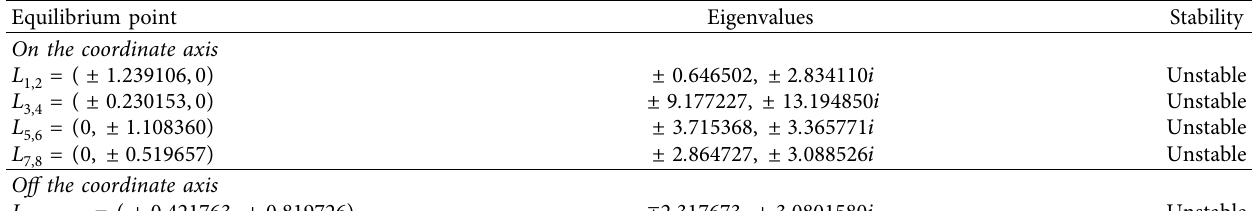
Table 4: Equilibrium points, eigenvalues, and stability status when b � 0 . 80 and a � 0 . 62